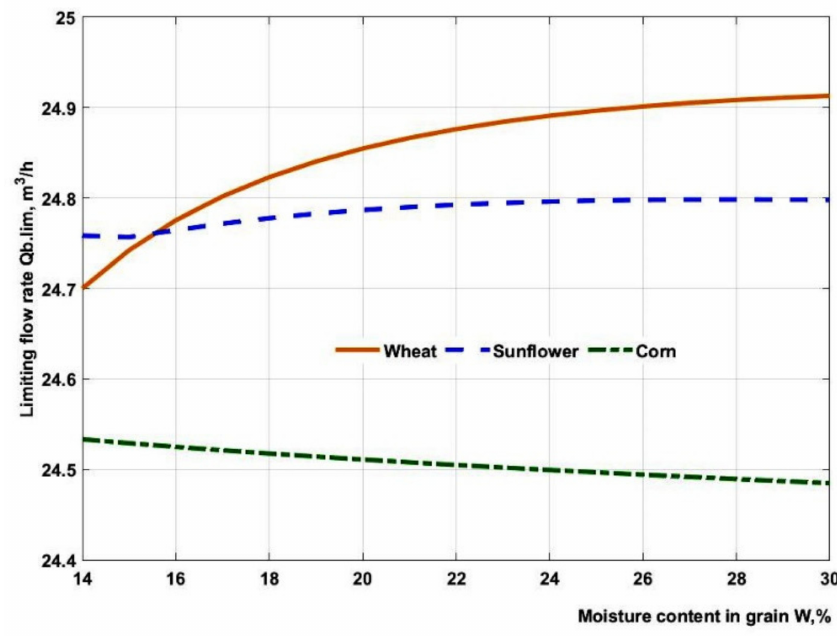
Figure 2. Dependence of limiting rate of grain flow in the hopper outlet hole on moisture